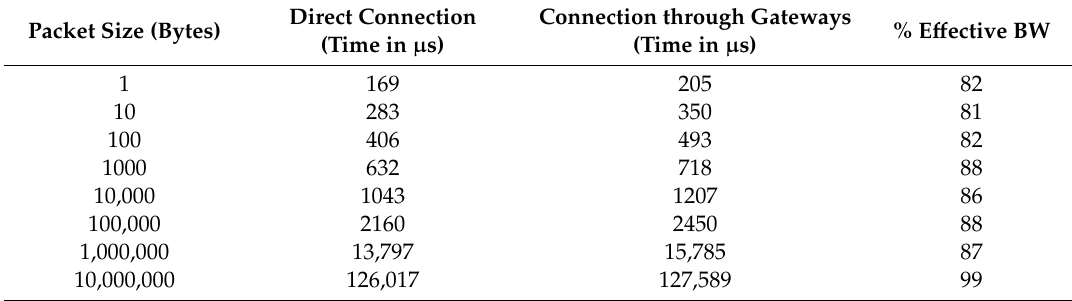
Table 12. Secure Shell (SSH) tunnel round trip time on Intel(R) Xeon(R) CPU E5-2620 v4 @ 2.10 GHz, CentOS